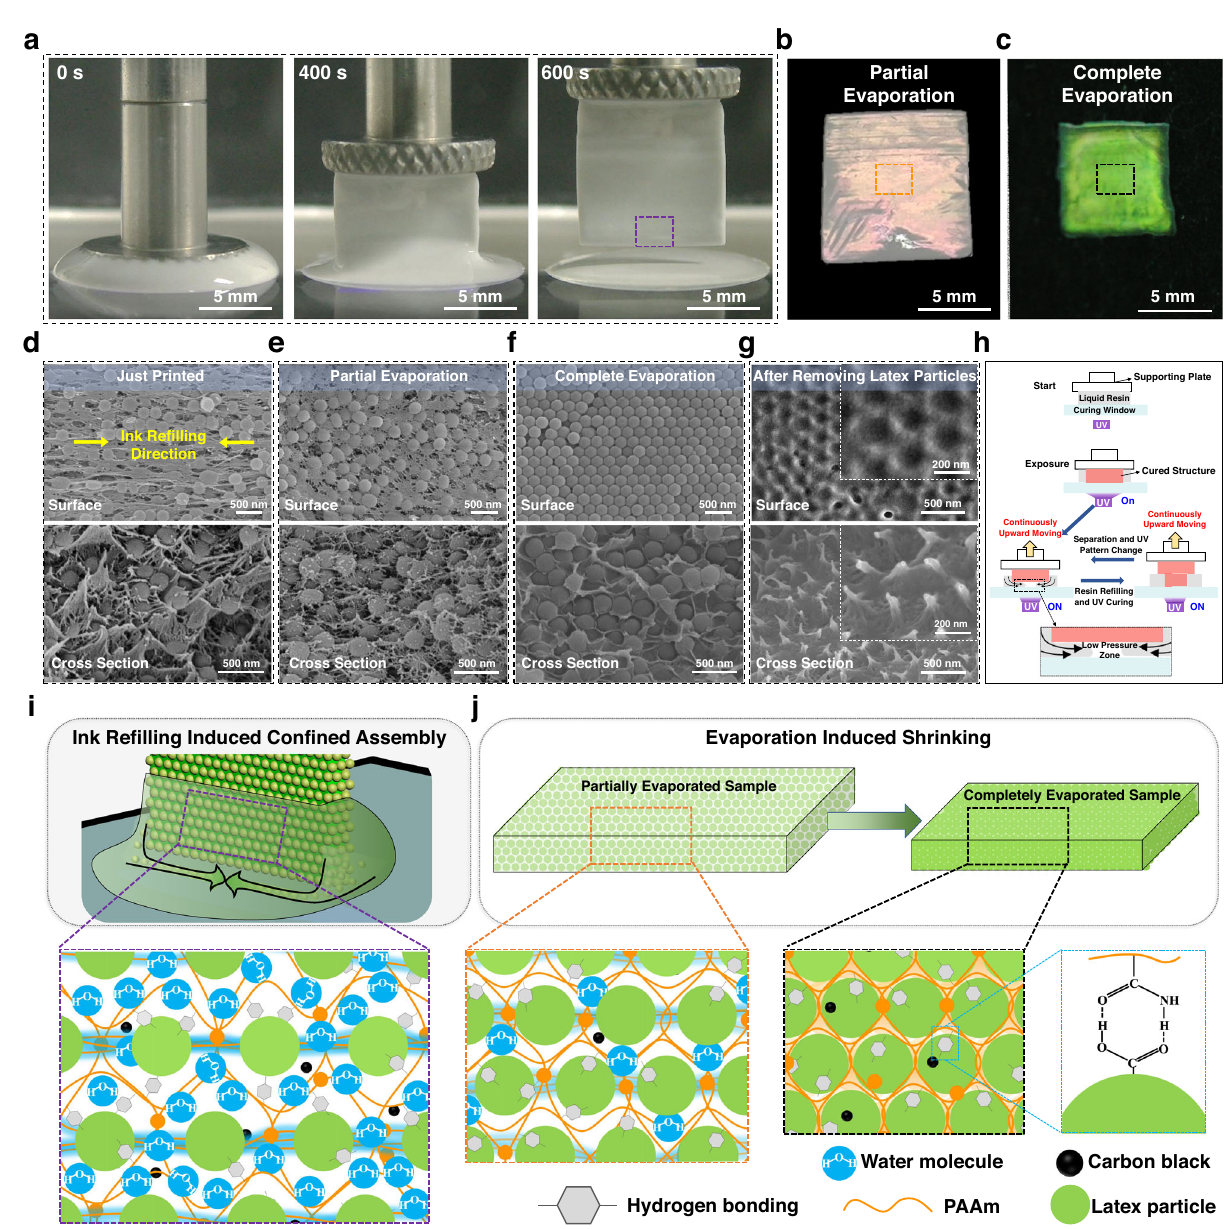
Fig. 2 | Mechanism of 3D structural color generation. a Time-sequence optical captures ofthe continuous DLP 3Dprinting process ofthe slab structureusing the UV-curablestructuralcolor ink,wherethe PSparticlediameter is 214nm. b Optical image of the 3D printed slab structure after partial evaporation, displaying red structural color. c Optical image of the 3D printed slab structure after complete evaporation, displaying green-yellow structural color. d – f Surface and cross- sectional SEM images of the just printed ( d ), partially evaporated ( e ), and com- pletely evaporated 3D structure ( f ). The yellow arrows in ( d ) represent the ink re fi lling direction during the continuous printing process. g Surface and